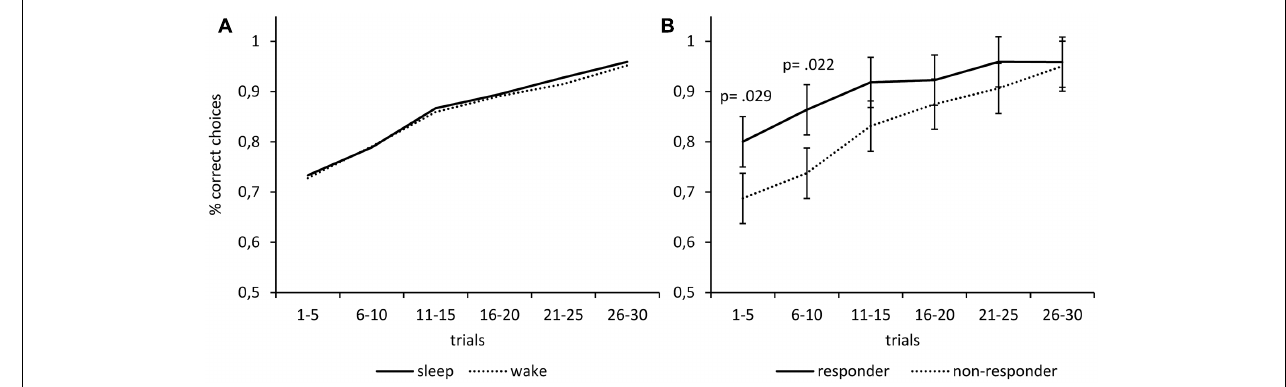
FIGURE 4 | Melatonin but not sleep fosters subsequent feedback learning. (A) The learning performance was almost identical after waking vs. sleep. (B) Participants who showed an increase in saliva melatonin during the nap (responders) subsequently displayed faster feedback learning as compared to non-responders. Differences occur very early in the task (trials 1–5) indicating that working memory might have supported feedback learning. The p -values correspond to two-tailed t